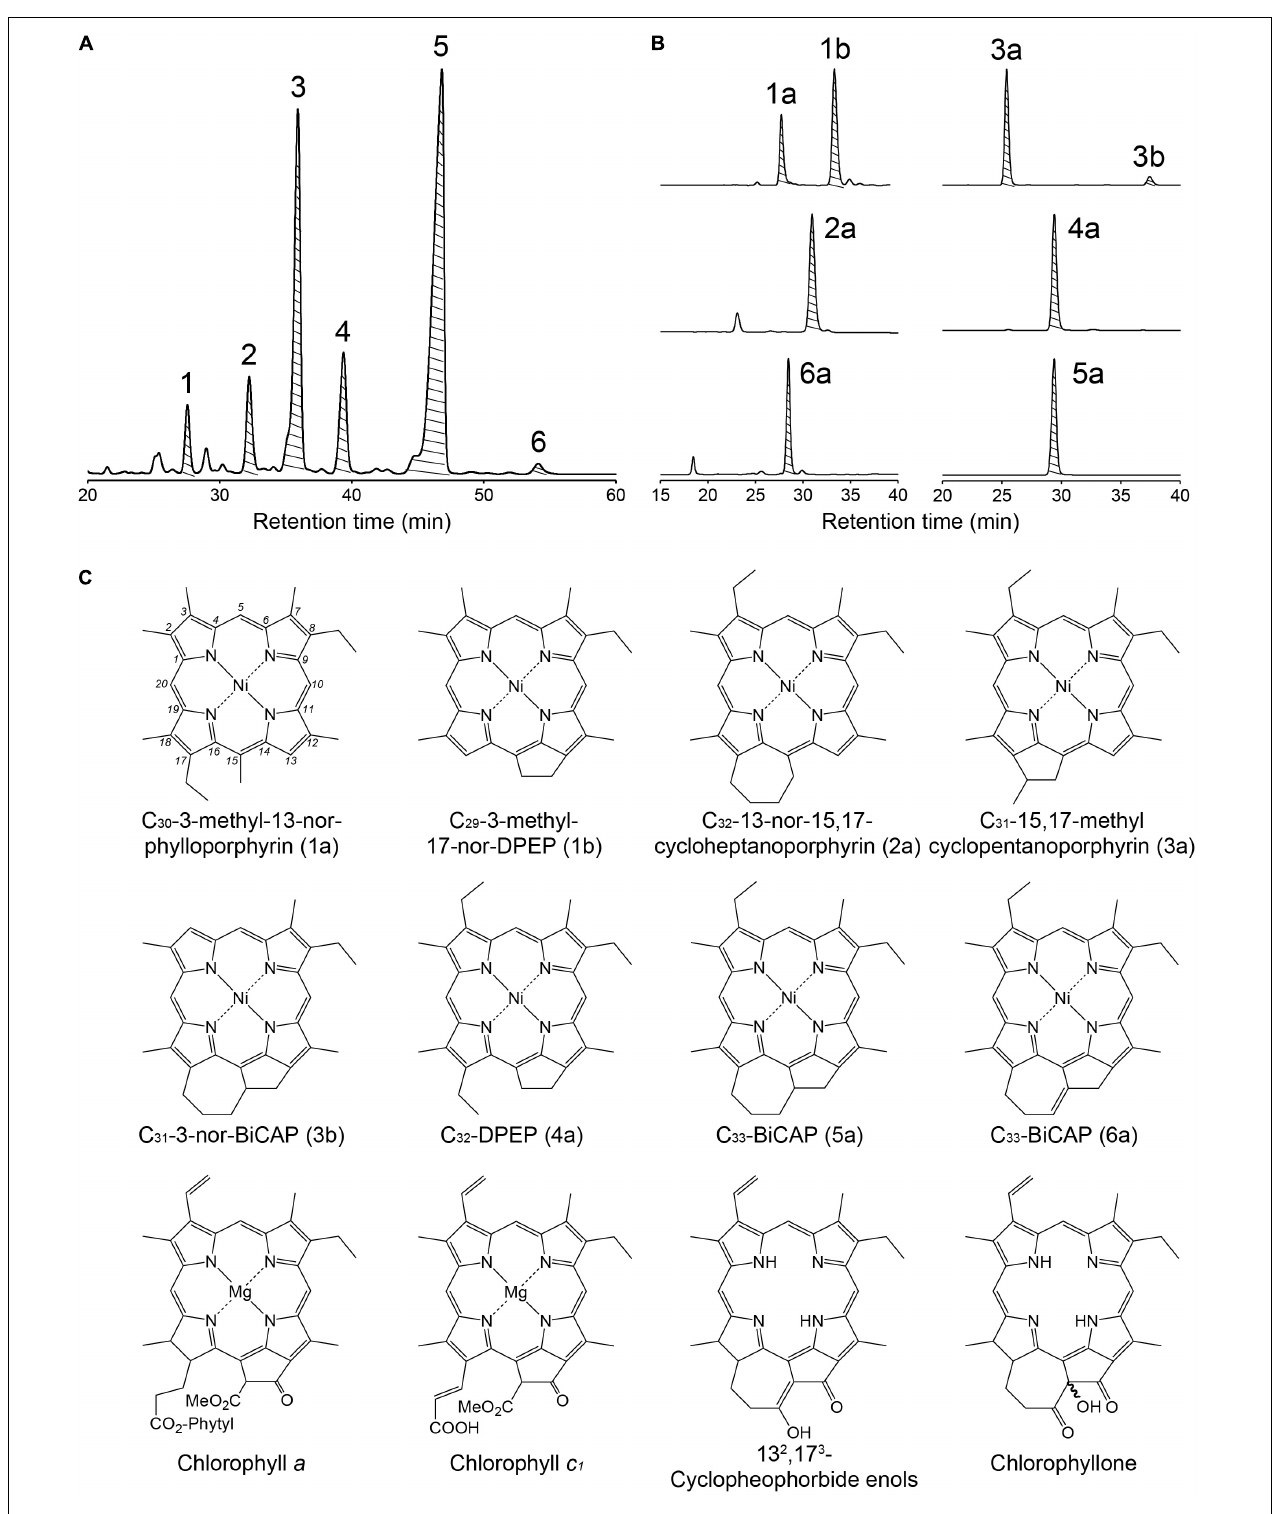
FIGURE 2 | (A) Chromatogram of the first-step, reverse-phase HPLC/DAD at 386 nm of the Ni alkylporphyrins fraction from the PLG 4 shale. Shaded peaks indicate the fraction collected for further purification using a normal-phase HPLC. (B) Chromatogram of the second-step, normal-phase HPLC/DAD at 386 nm of the peaks 1–6 collected in a reverse-phase step. Shaded peaks were fraction collected for measurements of carbon and nitrogen isotopic compositions and for determining the structures of porphyrins. (C) Structures of geoporphyrins and related compounds discussed in this study. Compounds 1a, 1b, 3b, and 6a are tentatively assigned.